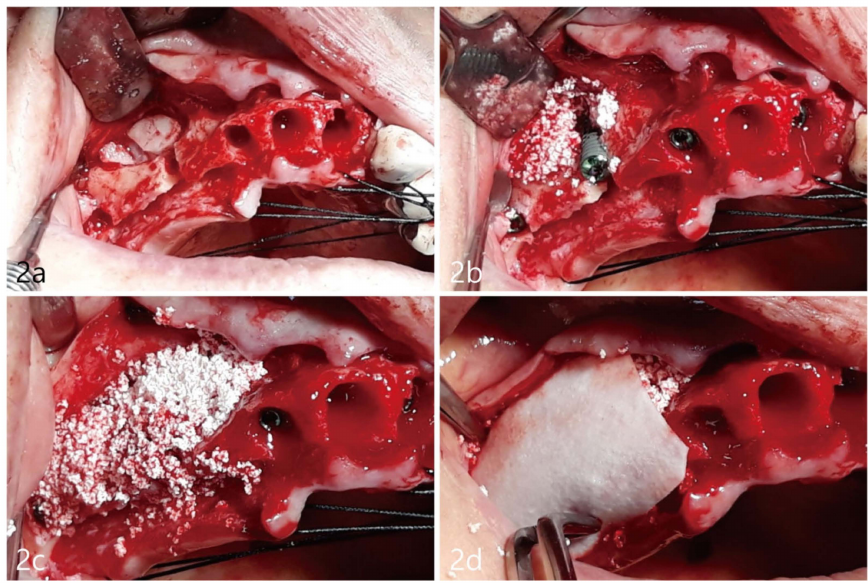
Figure 2. ( a ). A mucoperiosteal flap was reflected and an ovoid-shaped osteotomy was prepared on the buccal bone plate corresponding to the location of the inferior meatus. ( b ). Multiple fixtures